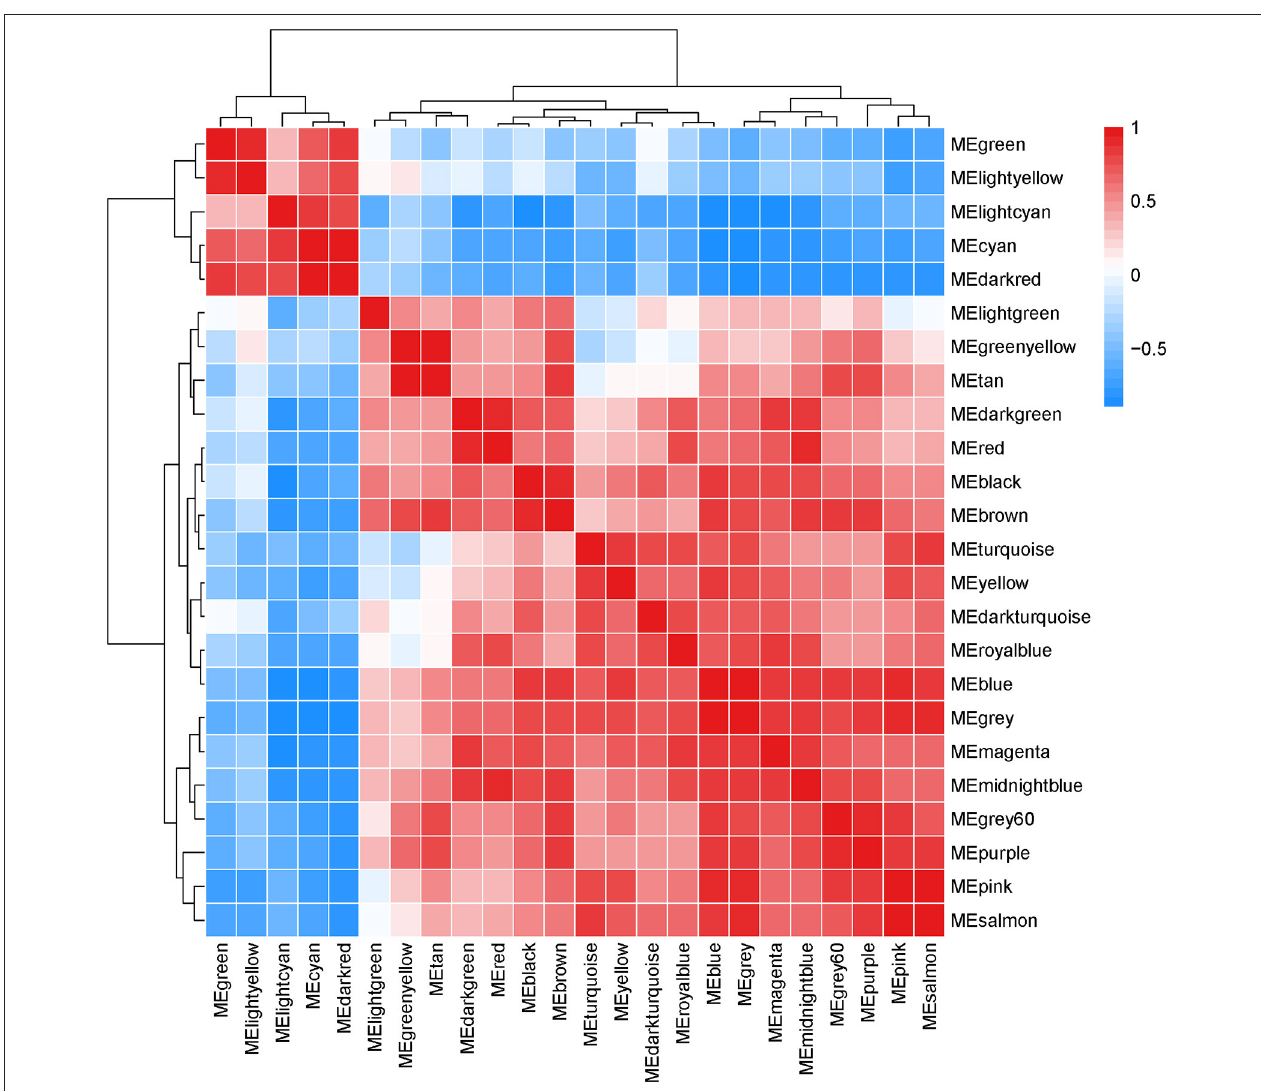
FIGURE 5 | Heat map based on the results of C plots, with darker red being higher